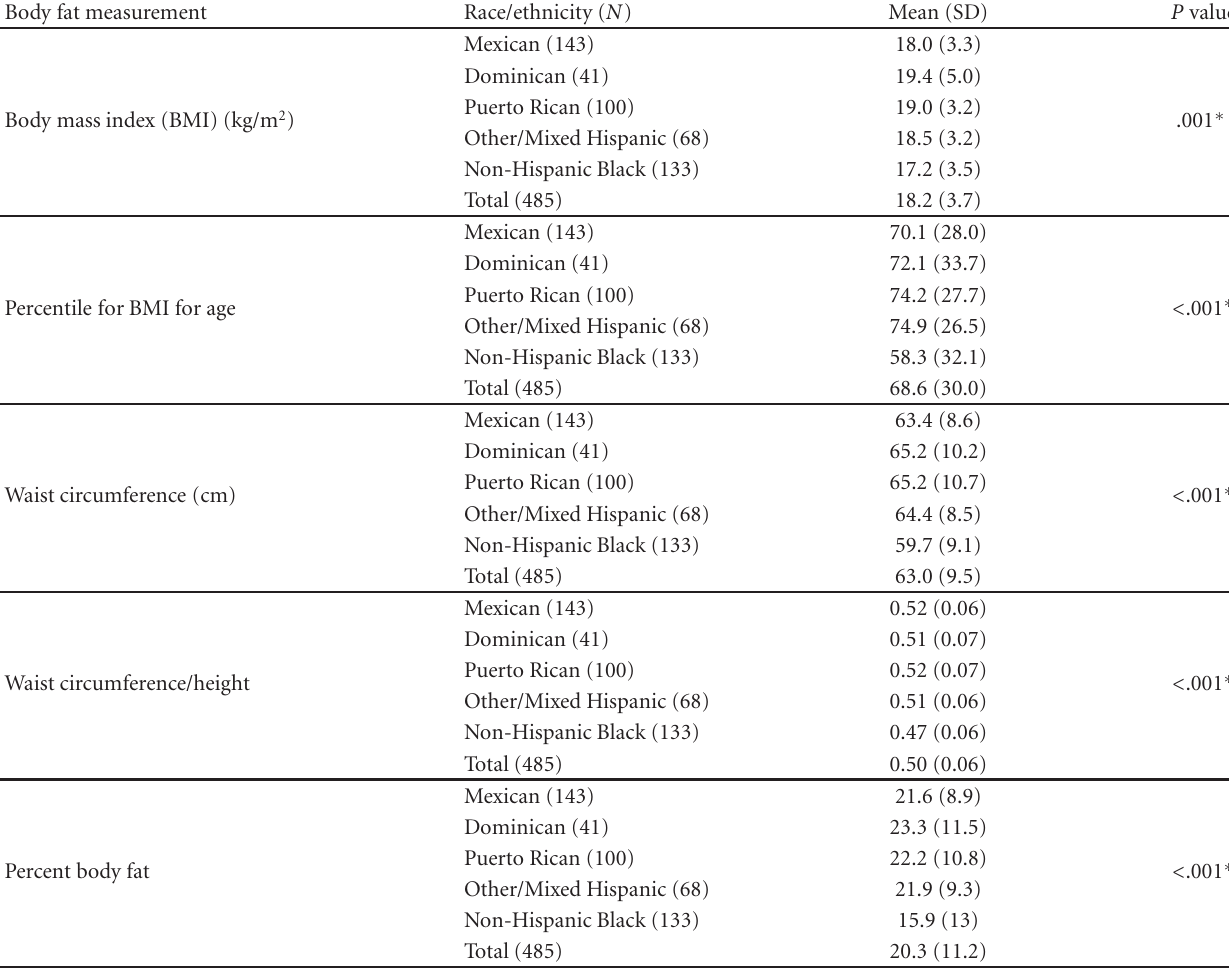
Table 3: Body fat measures by ethnicity in boys and girls aged 6-to-8